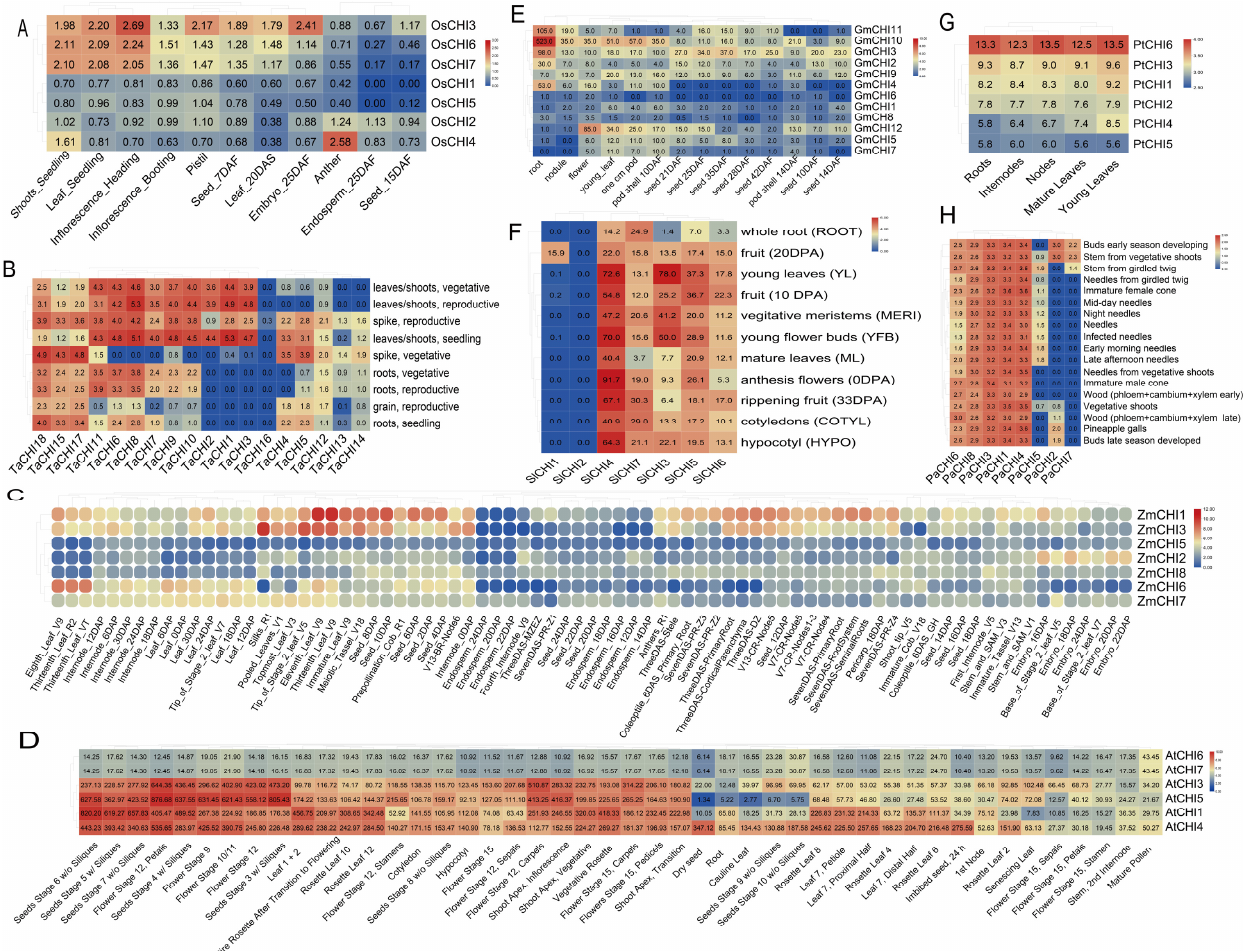
Figure 5. Expression patterns of CHI genes in various tissues from eight green plant species, including O. sativa ( A ), T. aestivum ( B ) , Z. mays ( C ), A. thaliana ( D ), G. max ( E ), S. lycopersicum ( F ), P. trichocarpa ( G ), and P. abies ( H ), respectively. The values in the color scale indicate the relative expression